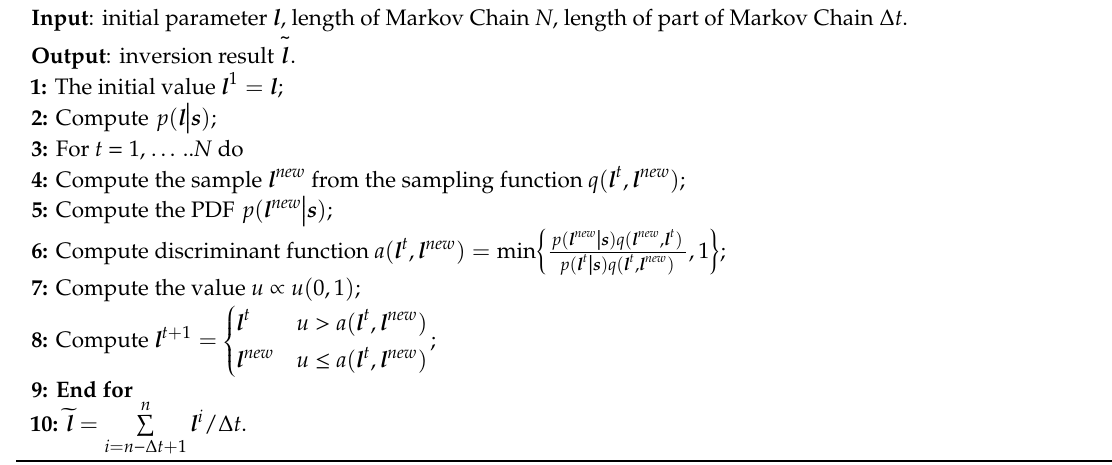
Algorithm 1 The process of Metropolis–Hastings (MH) sampling about vector